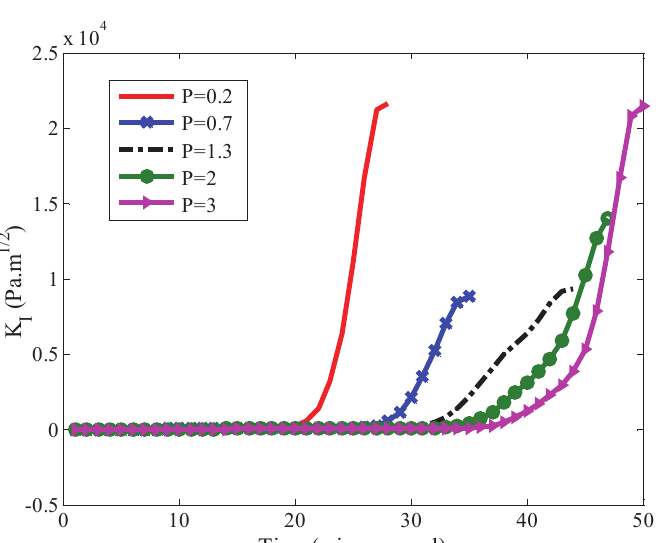
Figure 14: Plots of SIF vs. time for circumferential crack embedded in an epoxy/glass cylinder under impulsive tension.